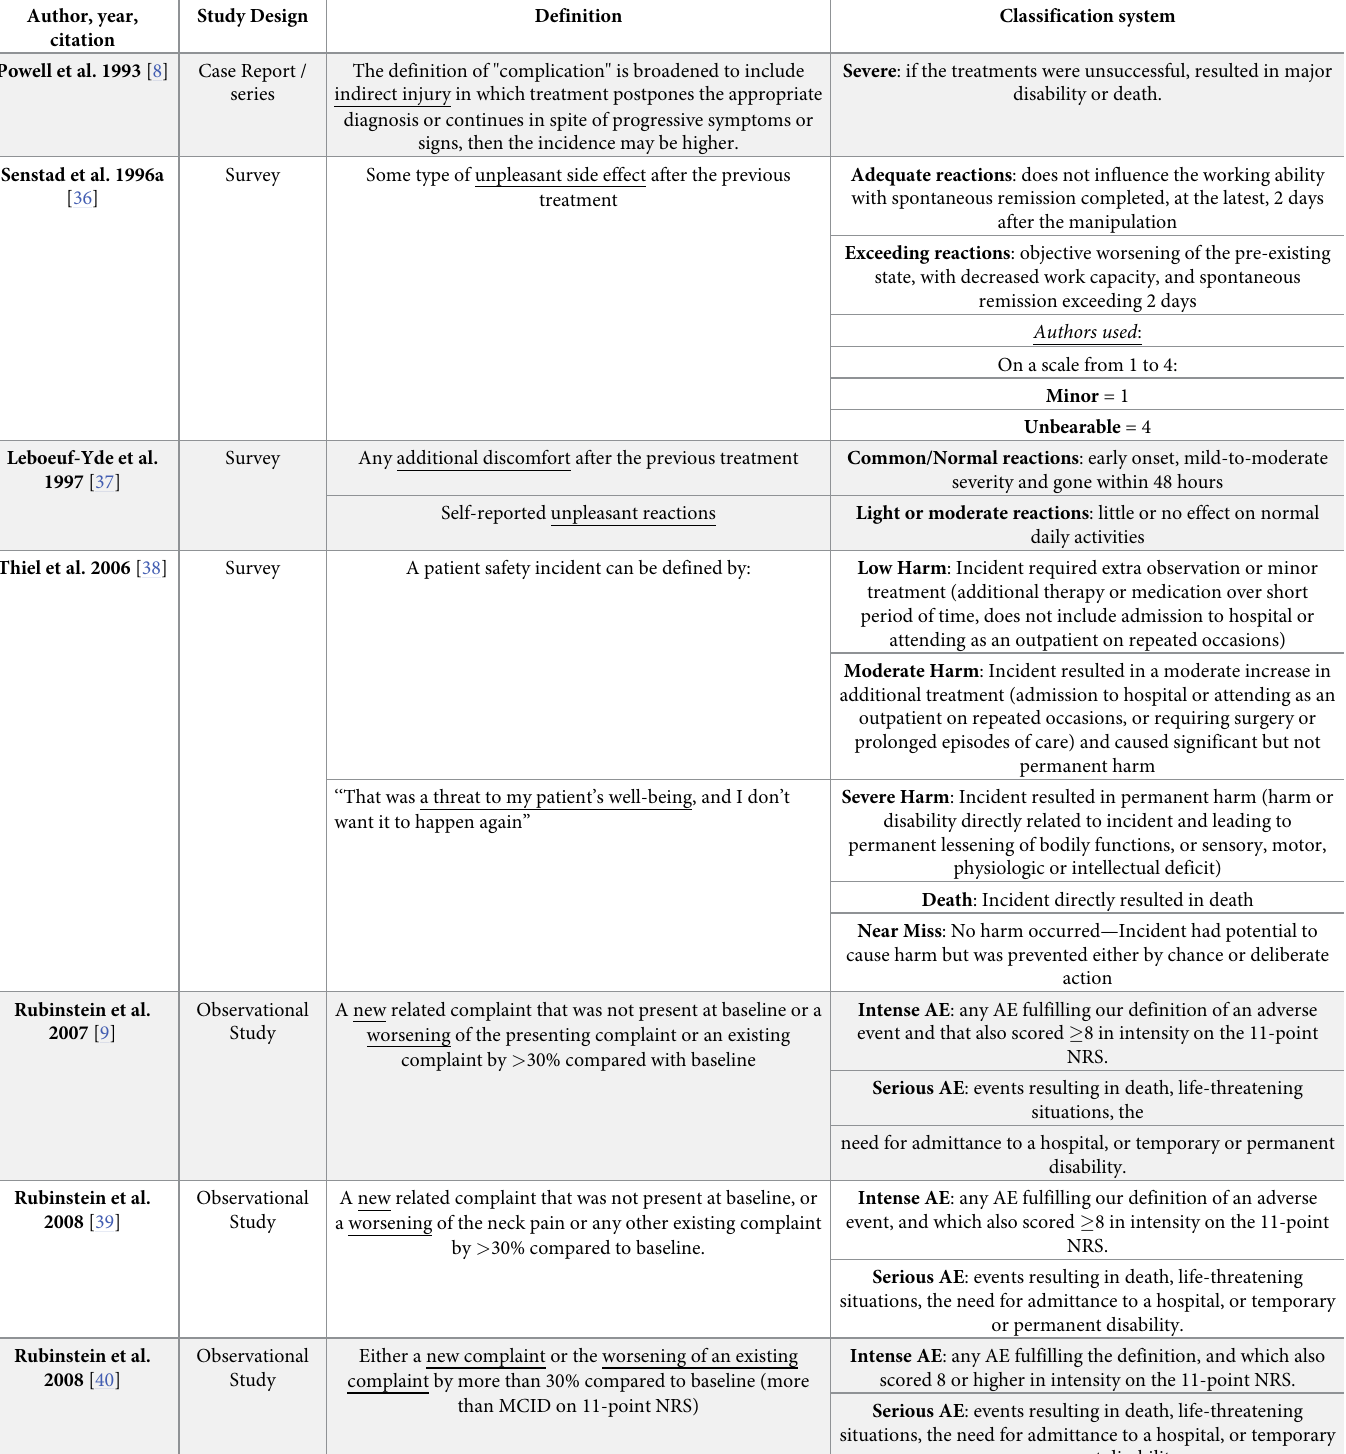
Table 2. Studies providing direct adverse event definition and classification system (n =